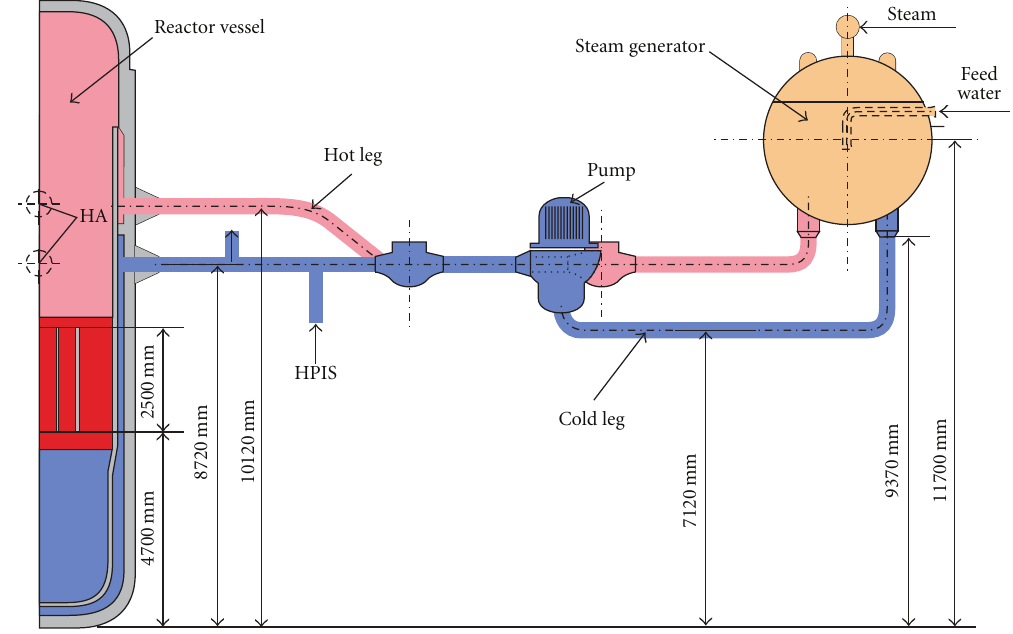
Figure 1: Schematic drawing of the primary circuit of the VVER-440 plant.